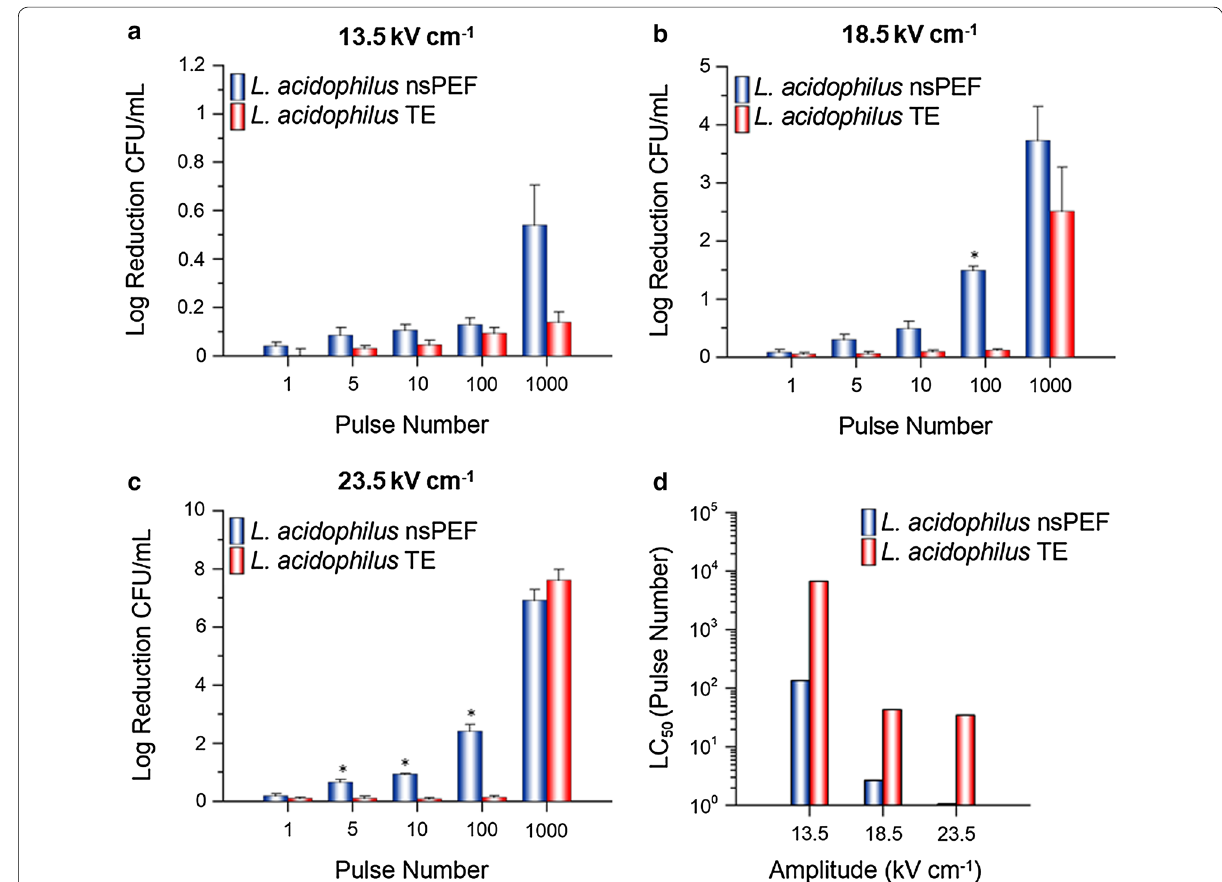
Fig. 4 L. acidophilus cell inactivation. Cell inactivation (log reduction CFU mL − 1 ) ( a – c ) and LC 50 values ( d ) for L. acidophilus exposed to a 600-ns PEF (blue) or its respective TE (red) at an amplitude of 13.5, 18.5 or 23.5 kV cm − 1 and 1, 5, 10, 100 or 1000 pulses. nsPEF and TE results are normalized to the sham and are the mean plus SE of three independent experiments (n CFU mL − 1 at each amplitude. An asterisk represents a statistically significant difference (p